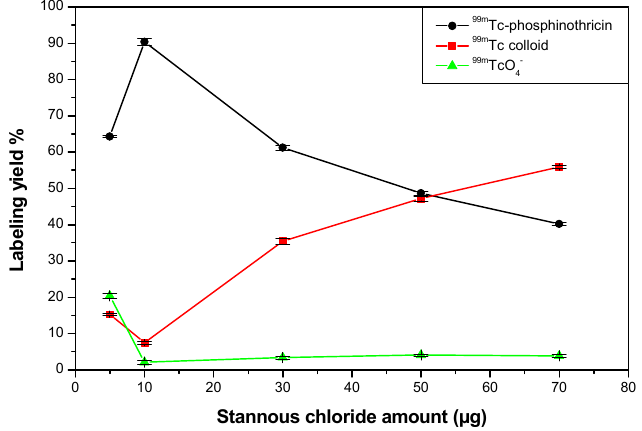
Figure 9. Radiochemical yield of 99m Tc-Phosphinothricin as a function of SnCl 2 ·2H 2 O amount. Reaction conditions: 1.5 mg of phosphinothricin, 100 µL (7.2 MBq) of 99m TcO 4 − solution, at a pH 8 for 15 min.